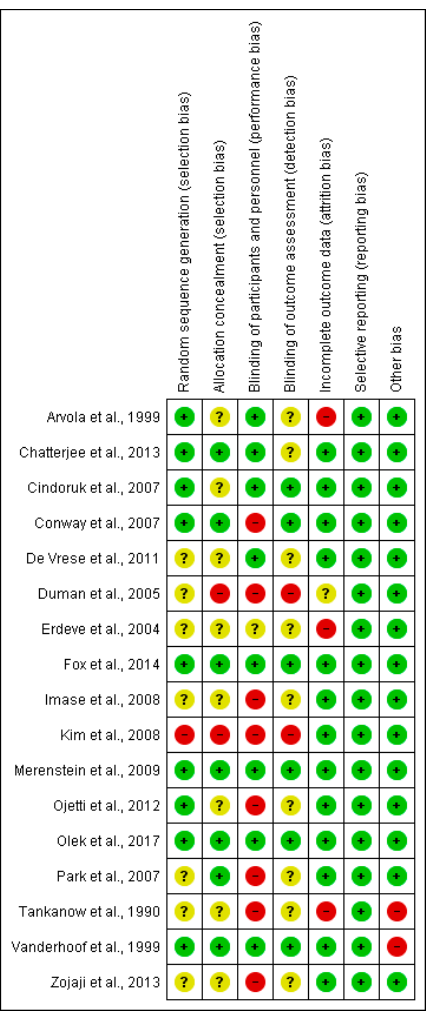
Figure 1. Risk of bias summary.